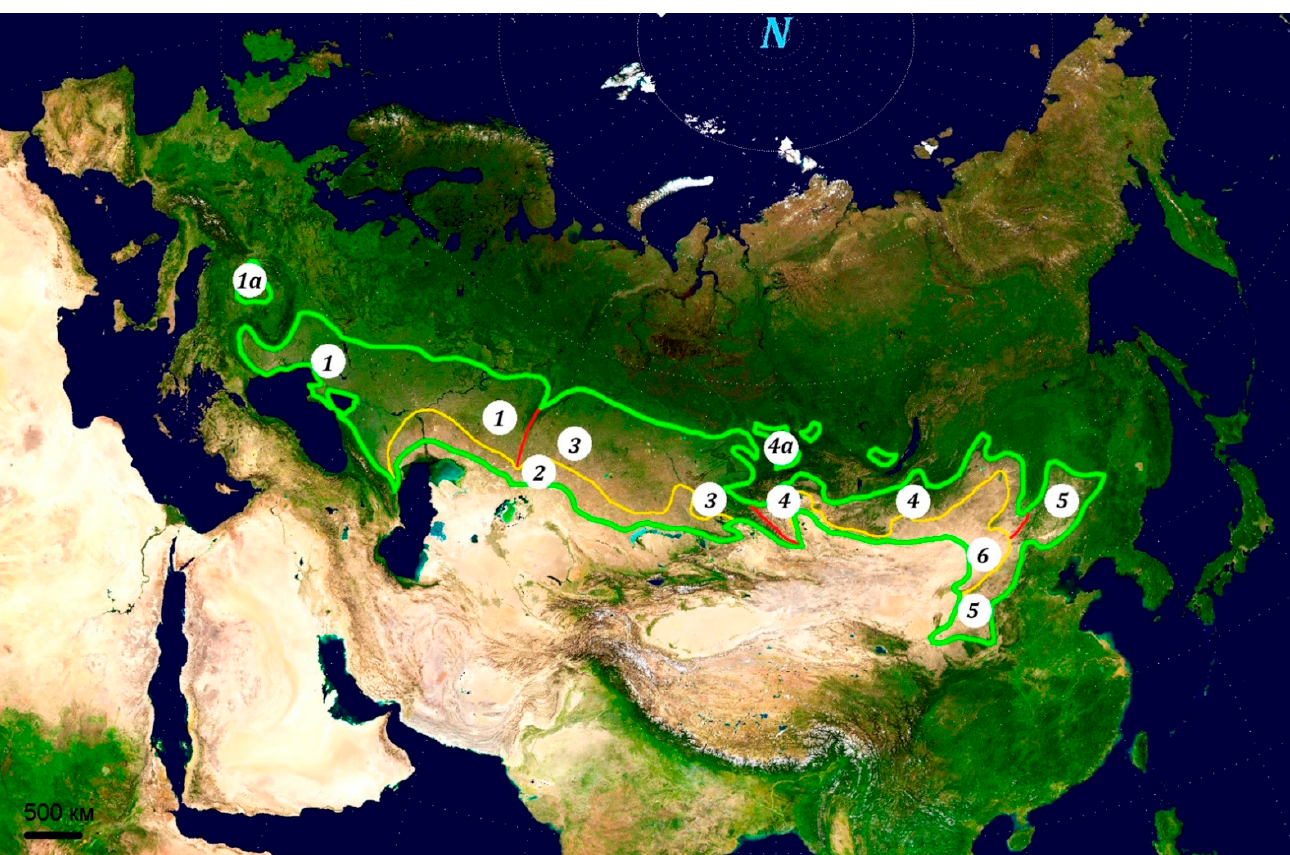
Figure 1. Distribution of the Eurasian steppes and their subregions. The boundaries of the steppe and the semi-desert life zones based on [1–4] with some changes and simplification. Boundaries: green—general outline of the Eurasian steppes including the semi-deserts and excluding the mountain steppes of South-West and Central Asia; yellow—boundary between the dry steppes and the semi-deserts; red—boundaries between western, central, and eastern parts of the steppes. 1 —European (western) parts of Scythian biogeographic subregion; 1a —Pannonian Plain; 2 —Kazakhstan Province of Saharan-Gobian subregion; 3 —West-Siberian parts of the Scythian subregion; 4 —Mongolian-Siberian parts of Scythian subregion; 4a —insular parts of forest-steppes and steppes of South Siberia; 5 —Dongbei Province of Scythian subregion; 6 —Mongolian Province of Saharan-Gobian subregion. The basic map is “A Two Point Equidistant Projection of Asia” (the control points are at 35° N 40° E and 35° N 140° E; the reticle is 10 degrees in latitude and longitude, with the central meridian at 90° E); the source image is a product of NASA’s Blue Marble Project public domain.